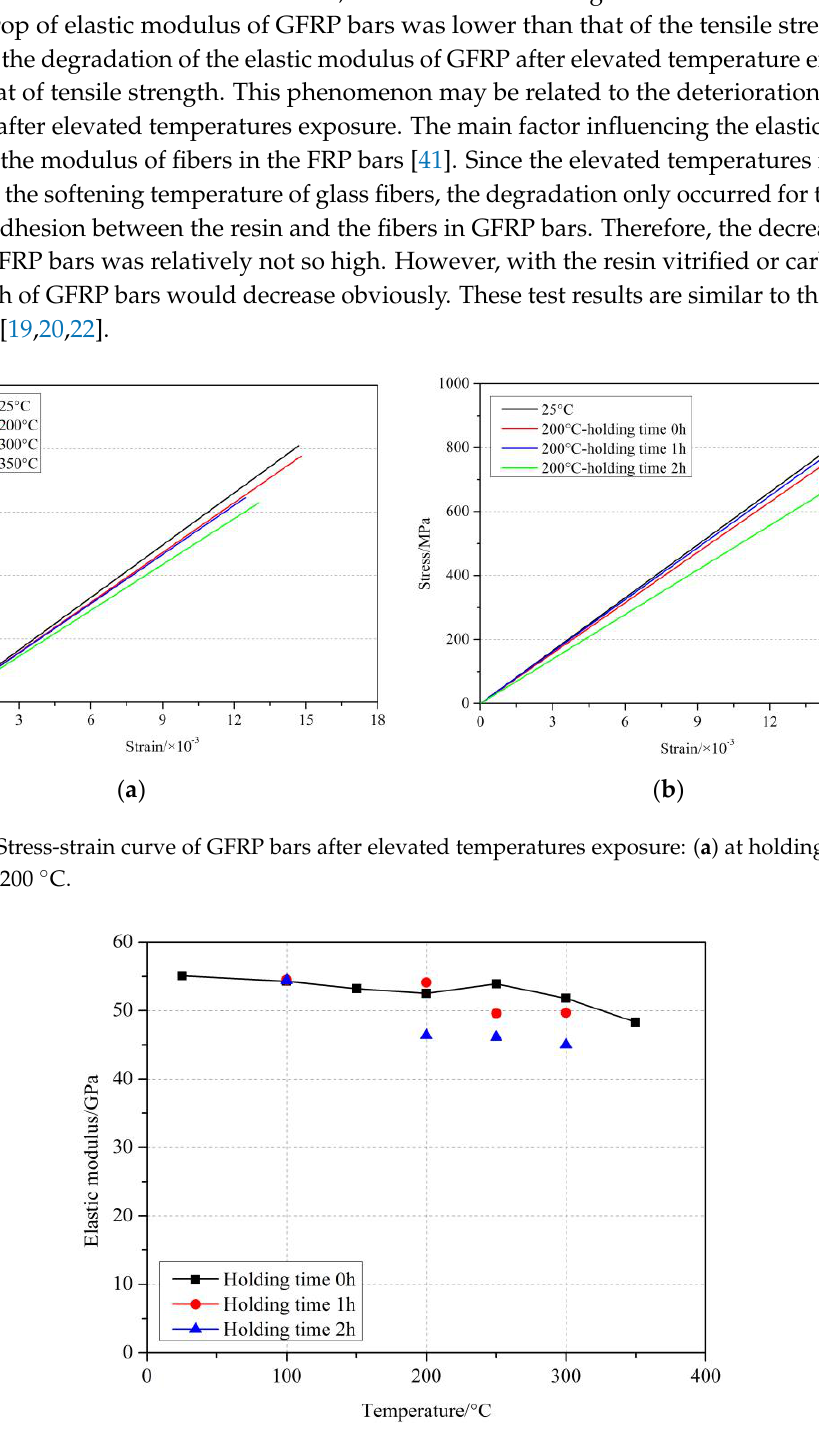
Figure 5. Elastic modulus of GFRP bars after elevated temperatures exposure.